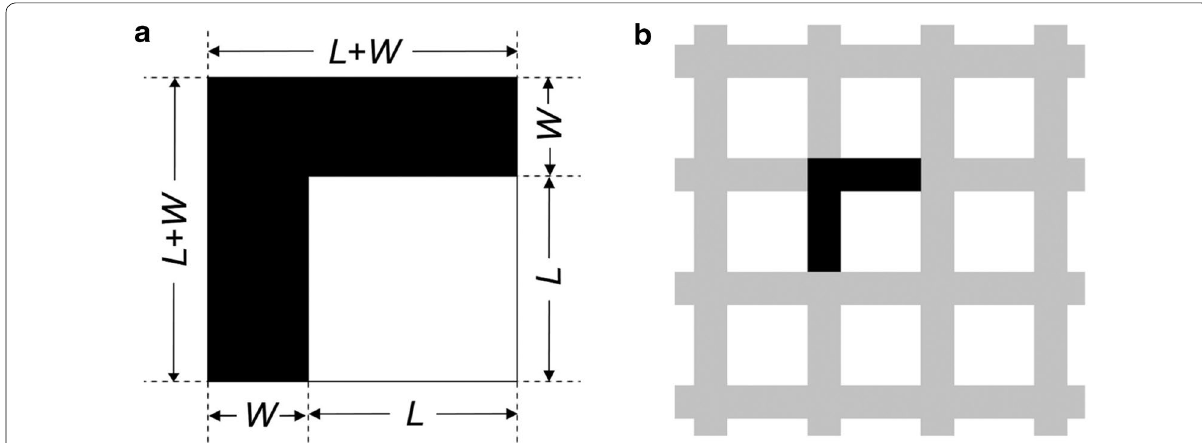
Fig. 1 Design of ( a ) the basic unit for ( b ) a model canopy (gap fraction between square openings